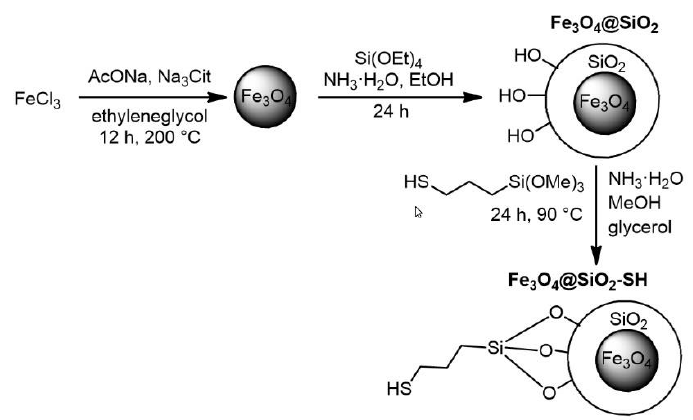
Figure 1. Three-step procedure for preparation of thiol-functionalized silica-coated iron oxide (Fe 3 O 4 @SiO 2 -SH) nanoparticles.